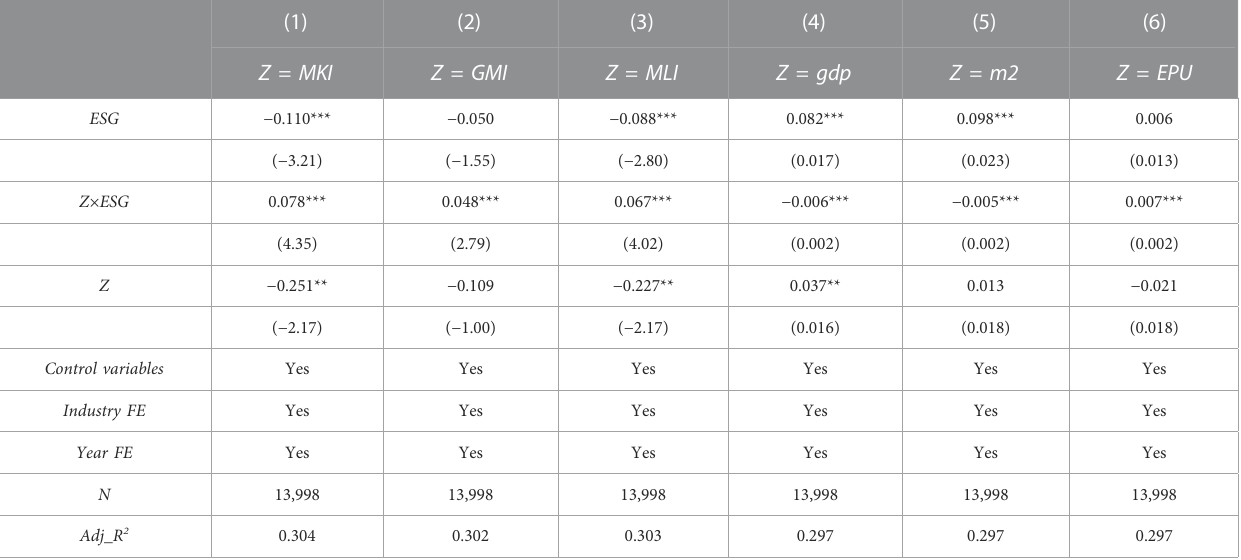
TABLE 9 Heterogeneity analysis results: Based on marketization process and macroeconomic